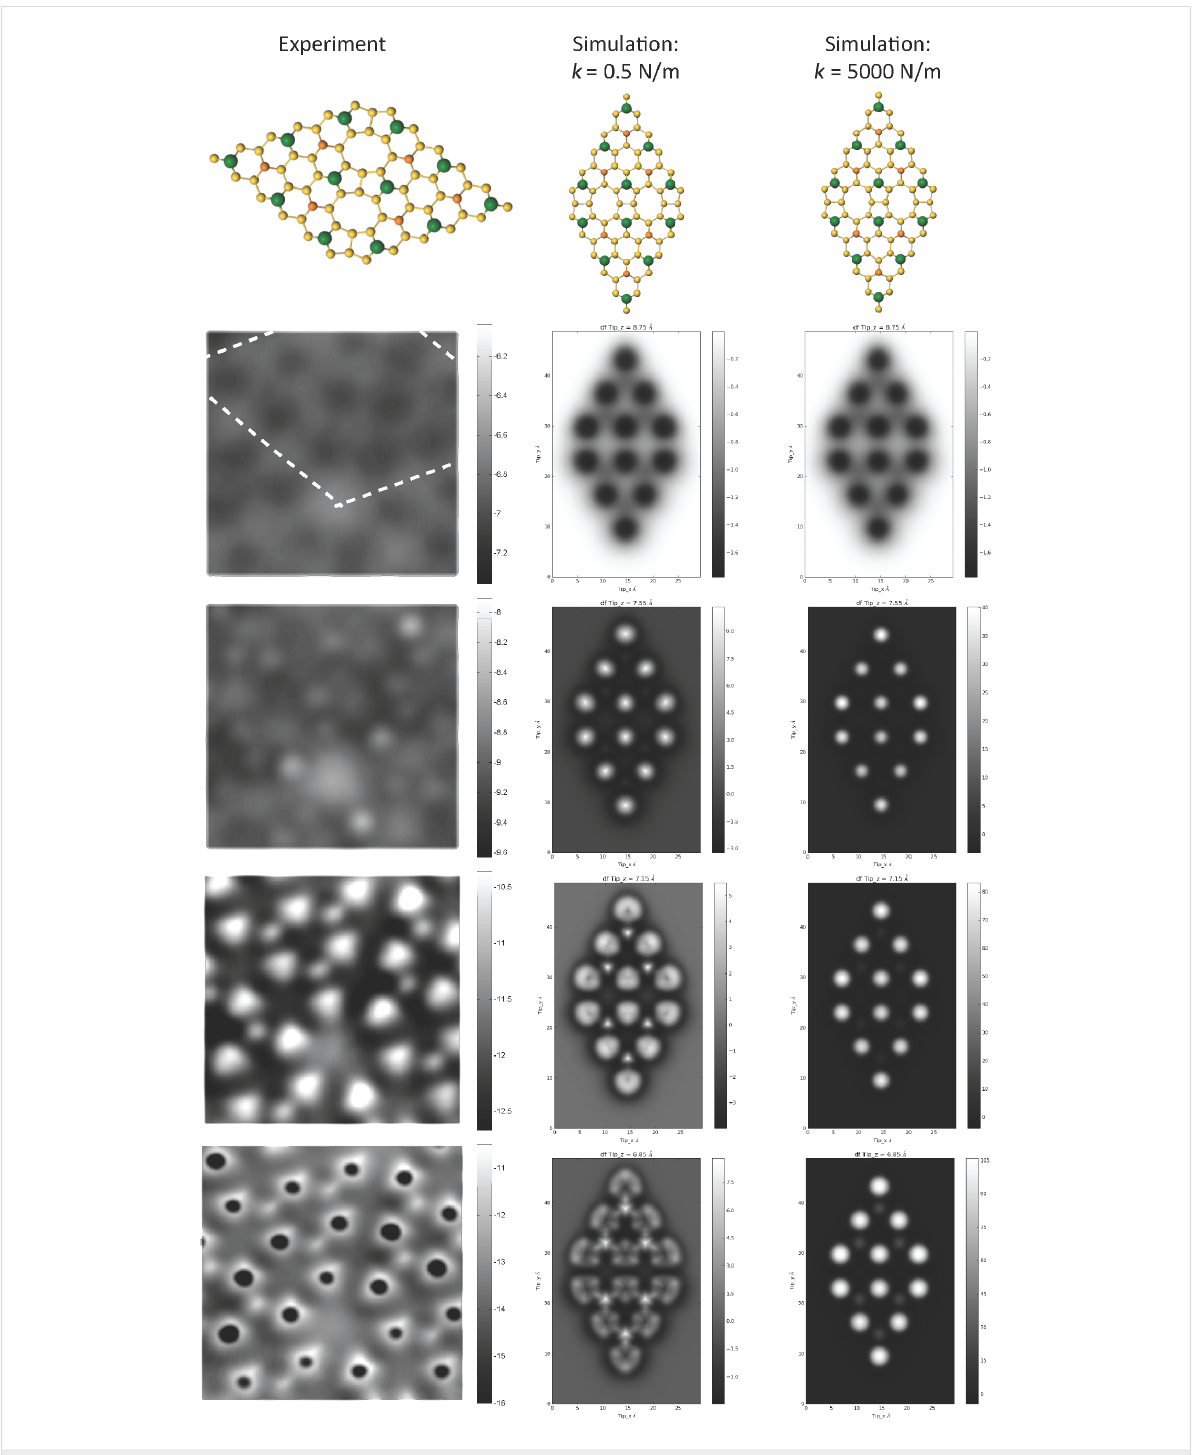
Figure 1: Left column: Experimental constant height Δ f images at decreasing tip–sample separation. Note a 10 point gaussian filter has been applied to all images to remove high frequency noise. Experimental parameters: A 0 = 110 pm, V gap = 0 V. Experimental tip heights relative to Δ f feedback setpoint (top to bottom): +0.186 nm, +0.104 nm, +0.032 nm, 0 nm. Image size 3.6 nm × 3.6 nm. Data acquired at 77 K. Middle column: simulated con- stant height force images over a Si(111)-7×7 unit cell using a flexible tip with stiffness k xy = 0.5 N/m. At close approach triangular adatoms and rest adatoms become apparent, strikingly similar to the experimental images. At very close approach an inversion occurs directly over the adatoms result- ing in a dark hole in the centre of the atom. Right column: simulated constant height force images using a tip with stiffness k xy = 5000 N/m. The atomic features remain spherically symmetric at all tip–sample separations. Simulated tip heights: (top to bottom) 0.875 nm, 0.755 nm, 0.715 nm, 0.685